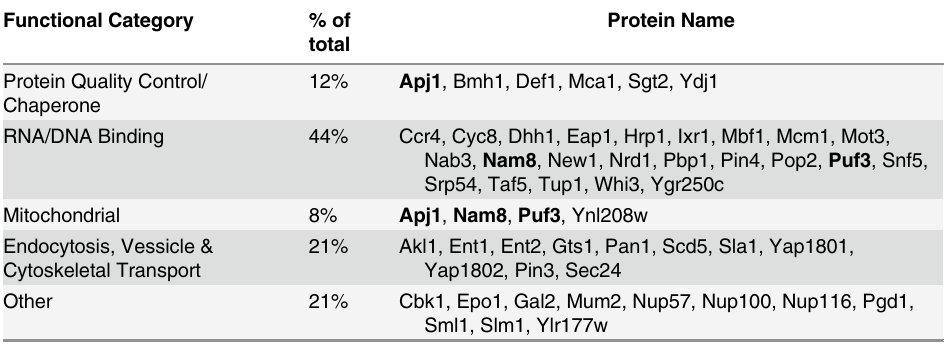
Molecular function determined by gene ontology and Saccharomyces Genome Database. Proteins in bold represent those with overlapping cellular functions; totals exceed 100% because of multiple categorizations. Yeast ribosomal proteins Rpl30 and Rps6b were